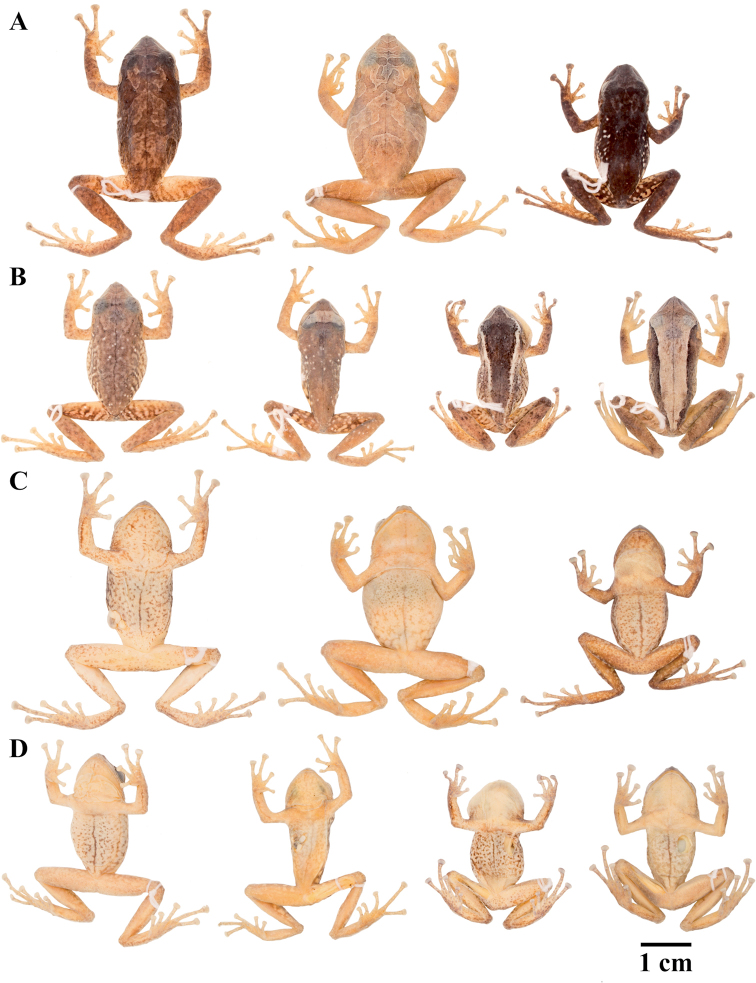
Color variation in preserved individuals of Pristimantis
totoroi sp. nov. A Dorsal view of (from left to right): QCAZ 32039 (female), QCAZ 16918 (female), QCAZ 16834 (male) B Dorsal view of: QCAZ 16920 (male), QCAZ 25124 (juvenile female), QCAZ 25135 (male), QCAZ 31502 (male) C Ventral view of specimens in (A) D Ventral view of specimens in (B) See Suppl. material 2 for locality data. All specimens are shown at the same scale.